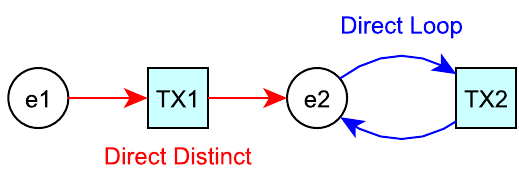
Figure 2. Example of 2_motif graph